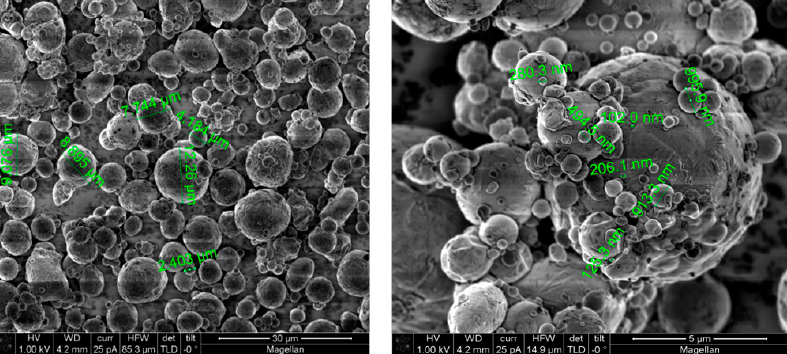
Figure 24. Two SEM images showing size distribution; 10 µm nominal aluminum powder specified.